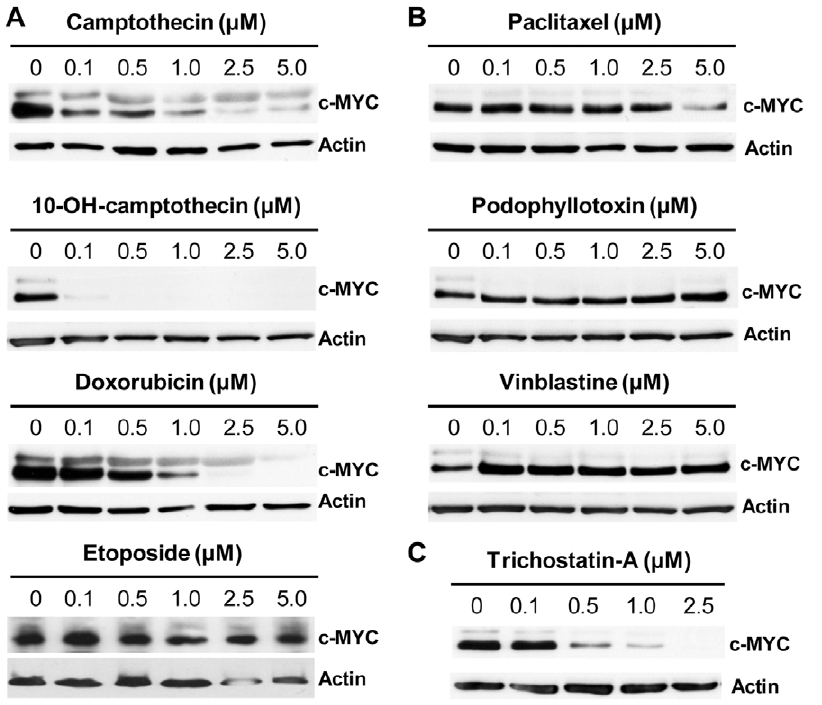
Figure 3. Effects of drug treatment on c-MYC protein levels. ( A ) Western blot analysis of c-MYC expression in p493-6 cells treated for 48 h with indicated concentrations of topoisomerase inhibitors ( A ), microtubule-targeting agents ( B ) or the HDAC-inhibitor trichostatin-A ( C ). Membranes were probed with antibodies recognizing c-Myc and Actin was used as a loading control.